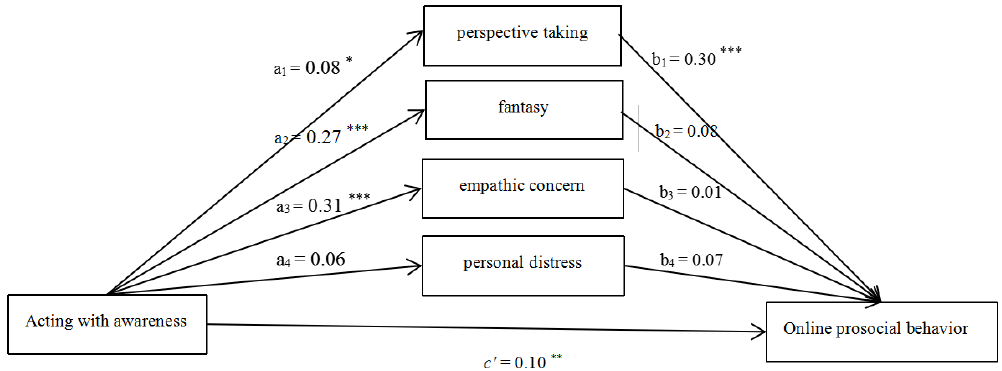
Figure 2. Mediating roles of empathy components (Describing as the predictor). Note: *** p < 0.001.